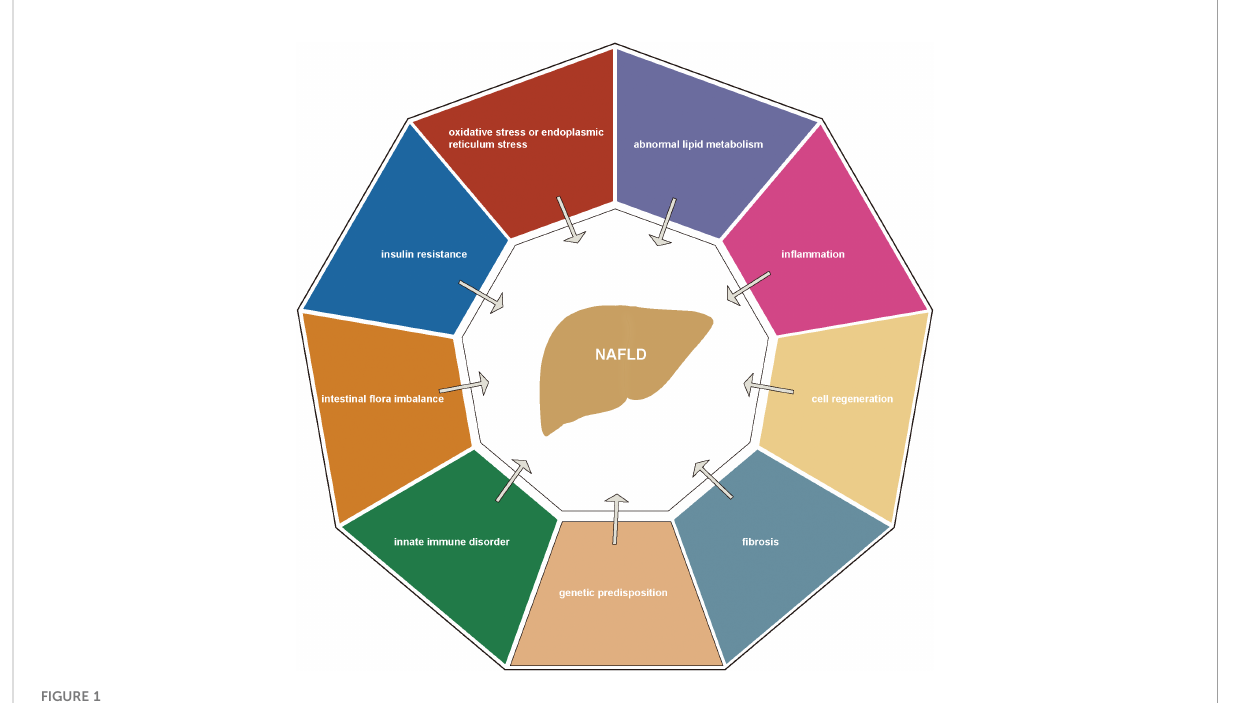
FIGURE 1 Current pathogenesis of